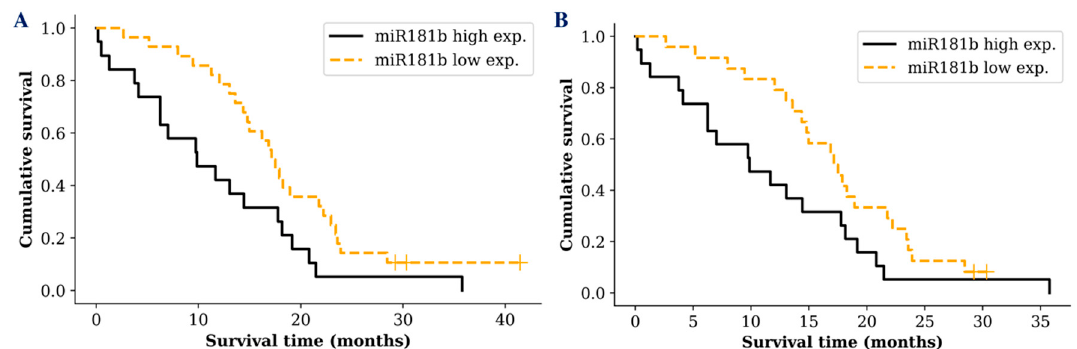
Figure 3. Kaplan-Meier survival curves comparing higher and lower miR-181b exosomal expression levels in: A —all GBM patients ( p = 0.017); B —GBM patients with IDH1 wild type ( p = 0.049). Censored cases indicated by a vertical line.